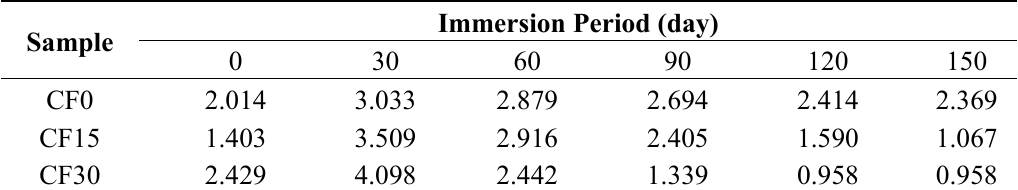
Table 4. Surface permeability coefficient of concrete under distilled water-eroding at different ages.